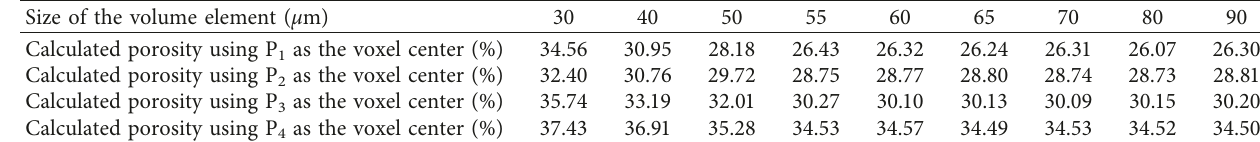
1 , P 2 , P 3 , and P 4 ) as the voxel centers.